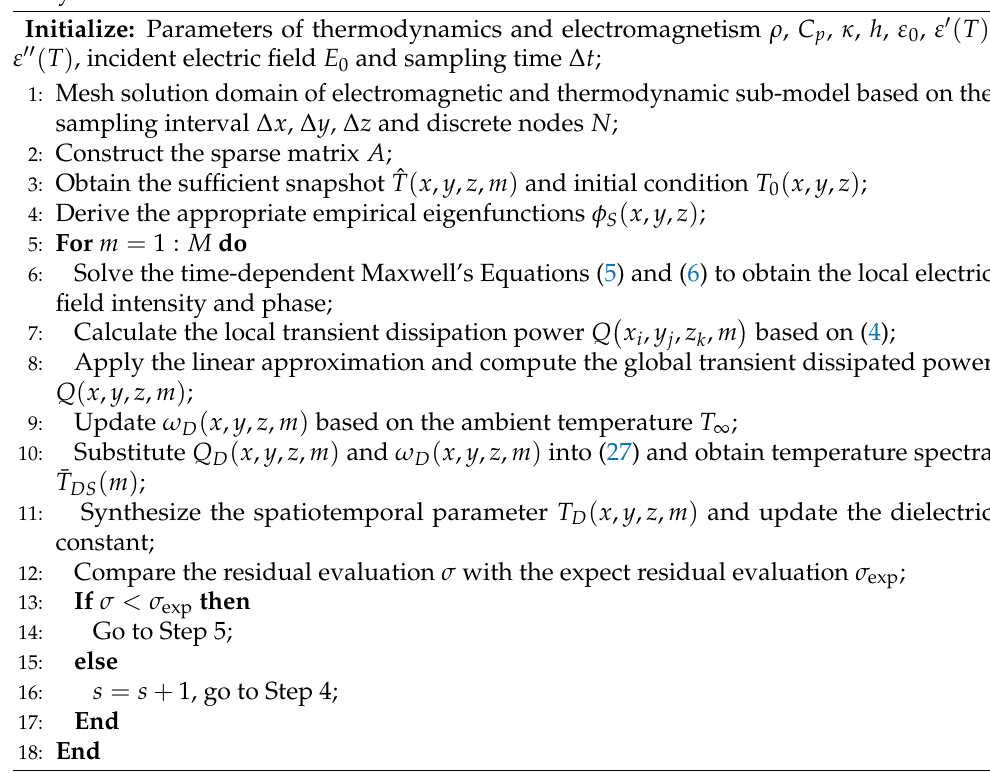
Algorithm 1 Detailed algorithmic procedure of model reduction for microwave heating Debye